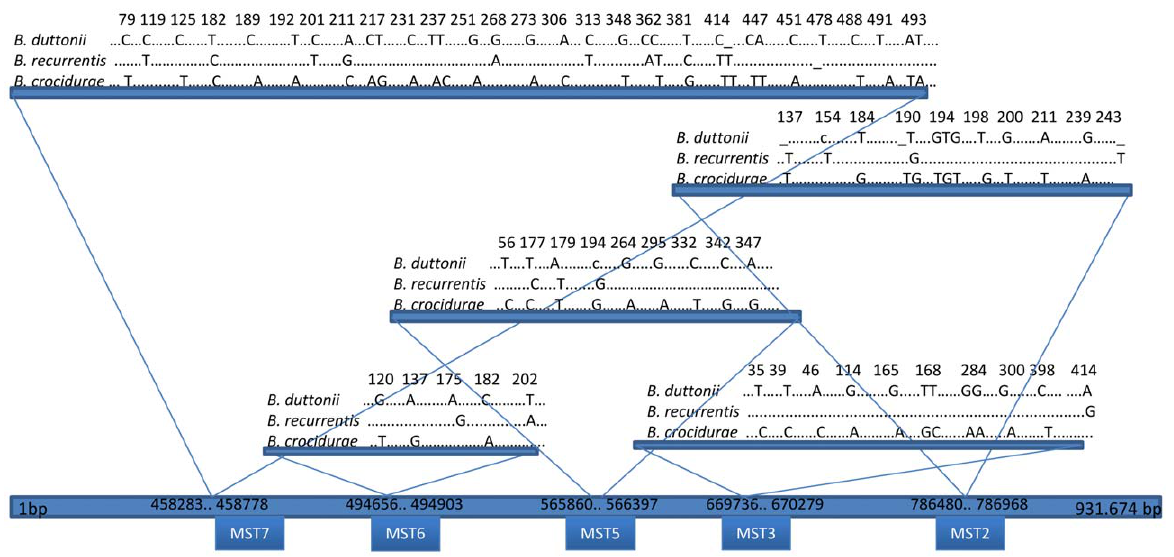
Figure 1. Distribution of spacers among the chromosome of B.duttonii and main differences within each spacer.